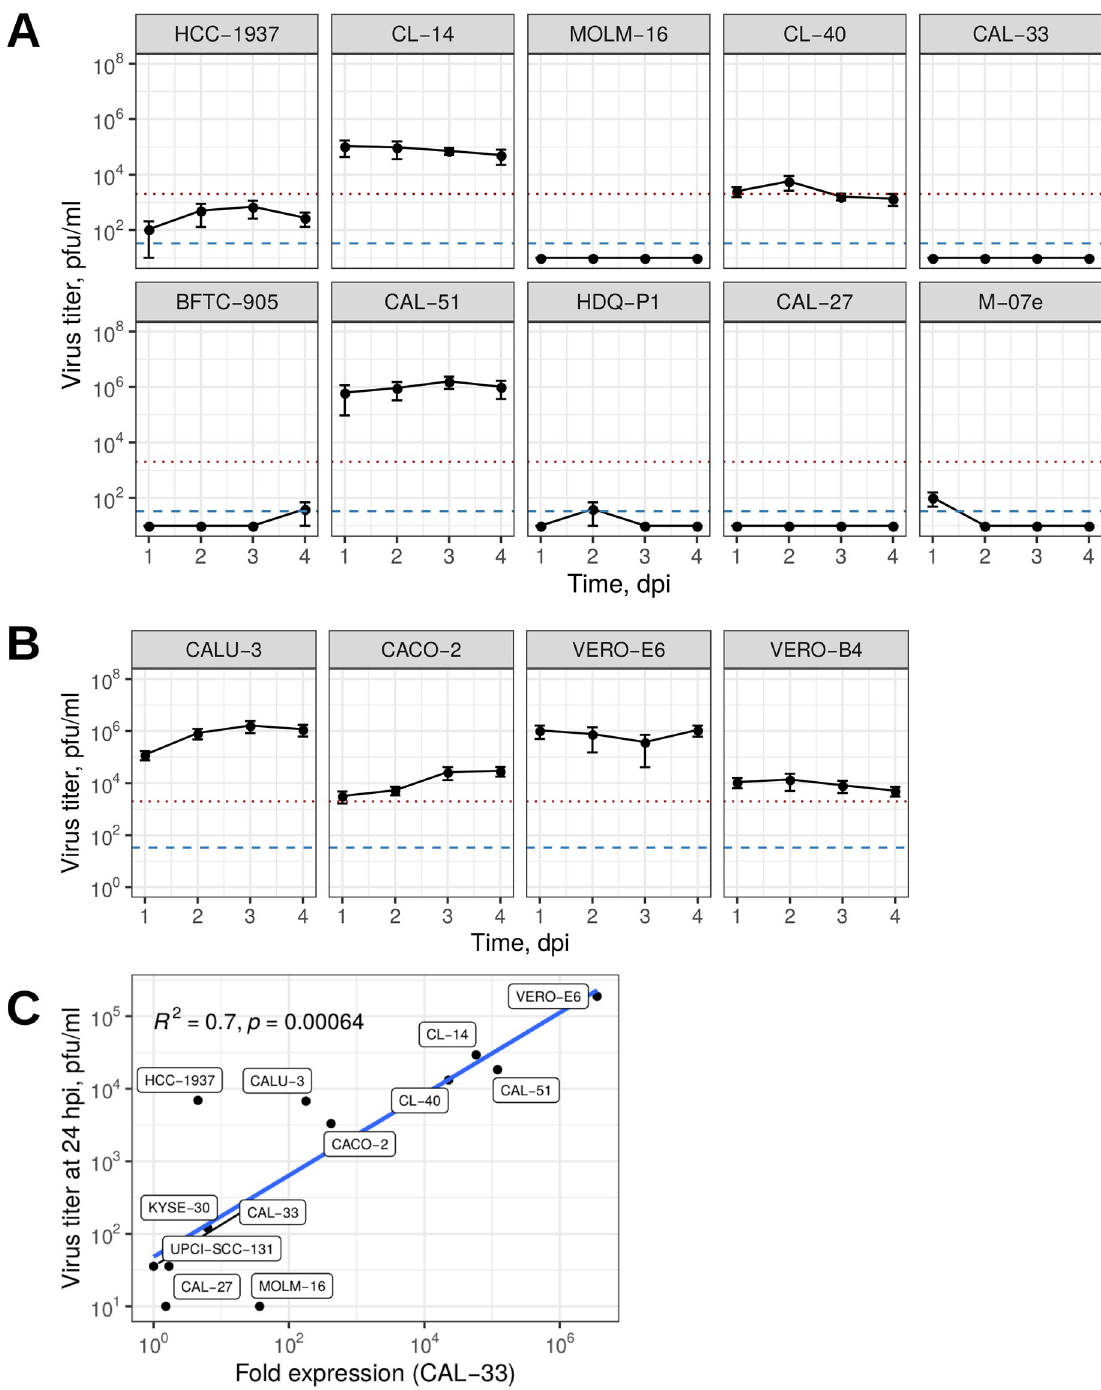
Fig 3. Susceptibility of tumour cell lines toward SARS-CoV-2 infection. Virus titers in the supernatant of infected cell lines at 1–4 days postinfection (dpi) determined by plaque assay for the top 10 ACE2 expressing cell lines (A) and controls (B). The red dotted line indicates the initial inoculum (2000 pfu/ml); the blue dashed line specifies the minimal limit of detection LOD 33.3 pfu/ml. Number of replicates varied between 3–8. pfu: plaque-forming units; mean values with SEM. (C) Predominant productive virus production in highly permissive cell lines seen in the correlation between qRT-PCR measured viral nucleoprotein N mRNA and releasing virions tested by viral plaques. Eight replicates served for the means of the viral titers and one representative expression fold change of two biological replicates qRT-PCR with three technical replicates. Note the logarithmic scaling for both x and